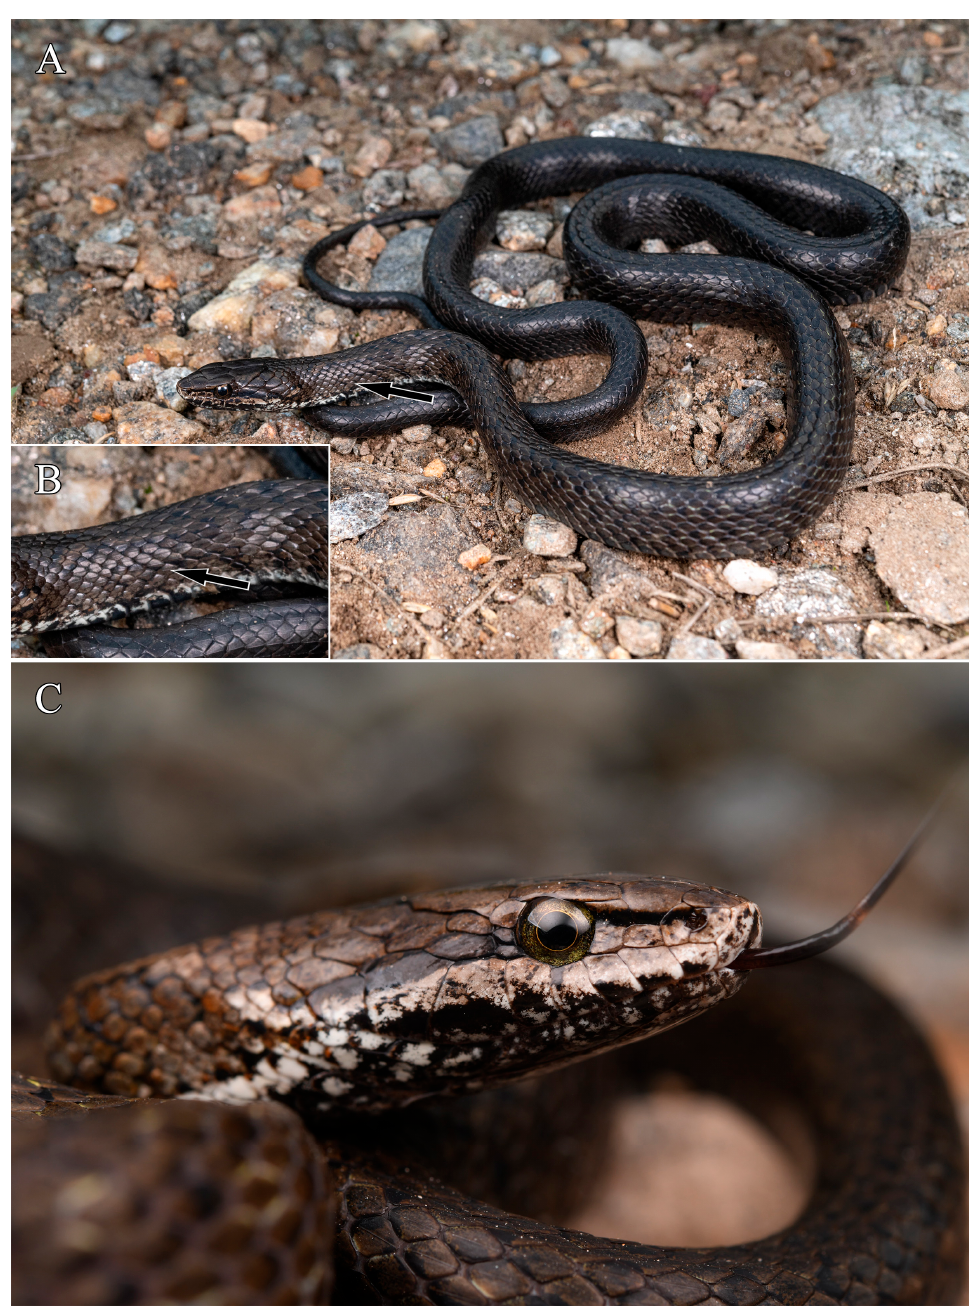
Figure 3. Herpetoreas platyceps showing color in life, Gyirong County, Xizang Autonomous Region, China. ( A ) general view; ( B ) close-up of dorsal scale rows at anterior body, showing moderate keeling on outer rows; ( C ) lateral head view. Photographs by Shuo Qi. Diagnosis. (1) body cylindrical, TL 755–927 mm; (2) tail moderate, TaL/TL